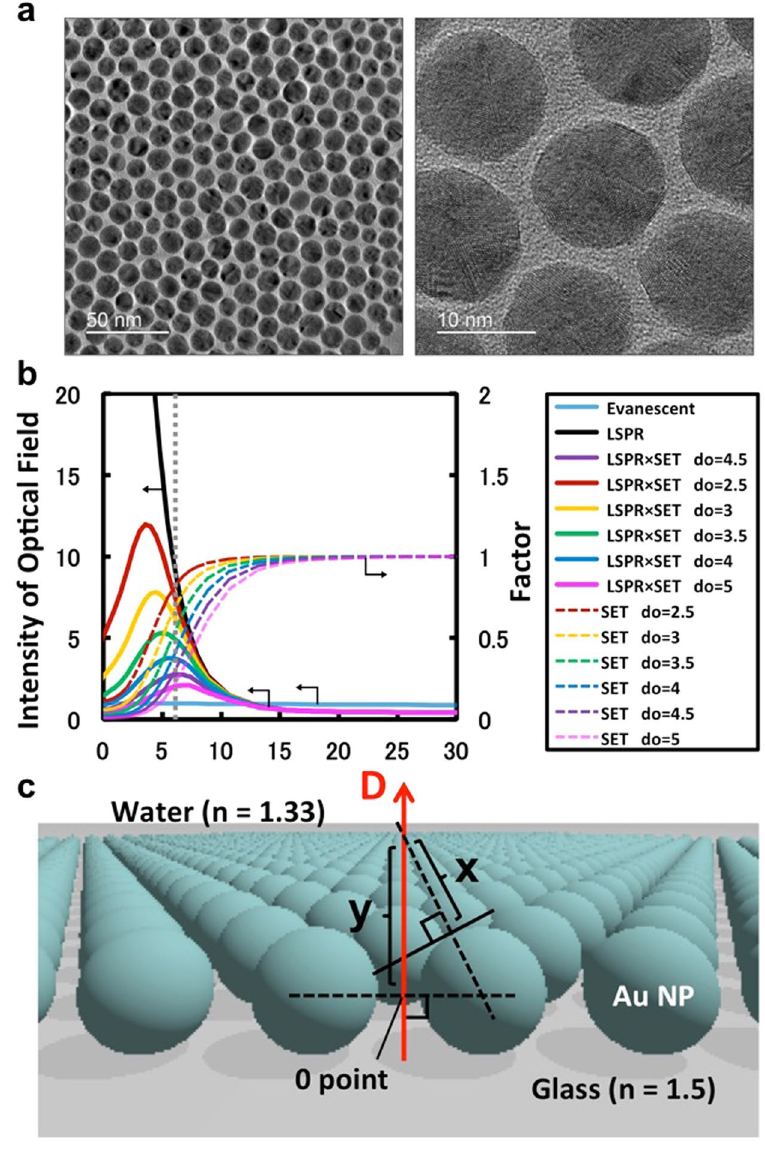
Figure 1. Structure and characteristics of the AuOA sheet. ( a ) TEM images of the AuOA NP sheet; the diameter of the gold core was ca. 12.6 nm and the gap distance was ca. 2.6 nm on average. ( b ) Intensity of the optical field under the influence of LSPR and SET. The black line corresponds to the LSPR field intensity excited on the AuOA sheet calculated by FDTD simulation, and the light blue line corresponds to the evanescent field excited under the TIR condition at the glass/water interface (incident angle: 65°) calculated by Fresnel simulation. The colored dashed lines present the fluorescence attenuation factor due to SET with various SET distances ( = d 0 ). The colored solid lines marked as ‘LSPR × SET’ are the LSPR field intensity obtained as the products of LSPR and SET. ( c ) Model of the AuOA sheet for the calculation. The data in ( b ) were obtained on line D , where the center position of the adjacent particles was set to D = 0. The attenuation factor by SET at each D position was calculated based on the distance to the closest particle surface (e.g., at the position of D = y, the ‘SET’ value was calculated based on the distance of d =